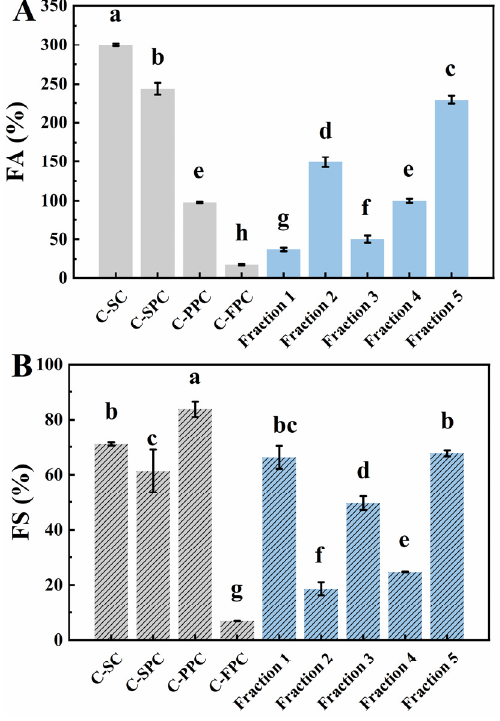
Figure 8. FA ( A ) and FS ( B ) of flaxseed protein-polysaccharide natural fractions and C-SC, C-SPC, C-PPC, and C-FPC. FA and FS represent the foaming ability and foaming stability, respectively. Comparisons were performed between values of the same serious and those without same letter(s) differed significantly at p < 0.05.